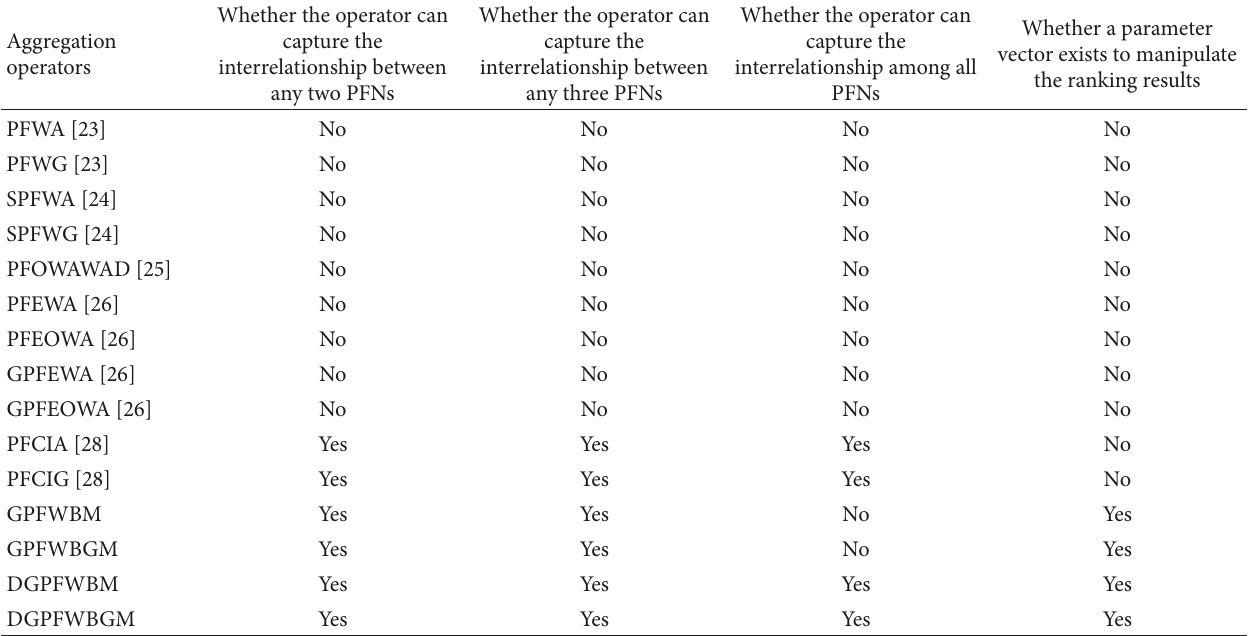
Table 2: Comparison of the different operators.